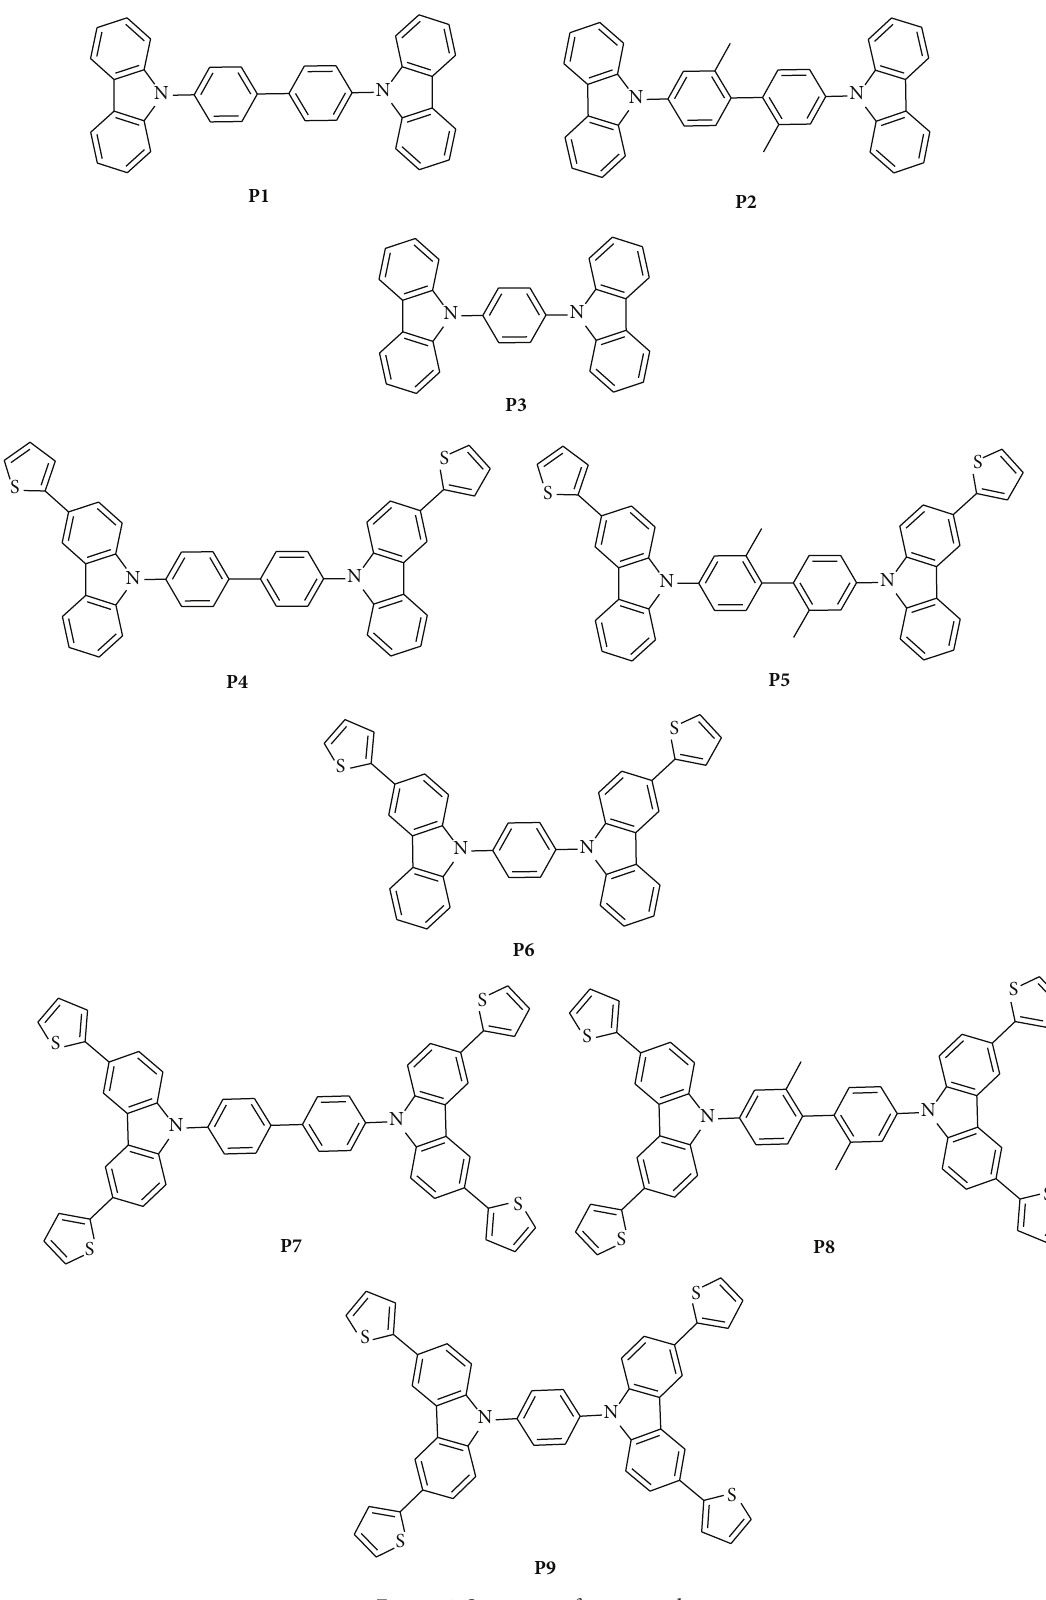
Figure 1: Structures of